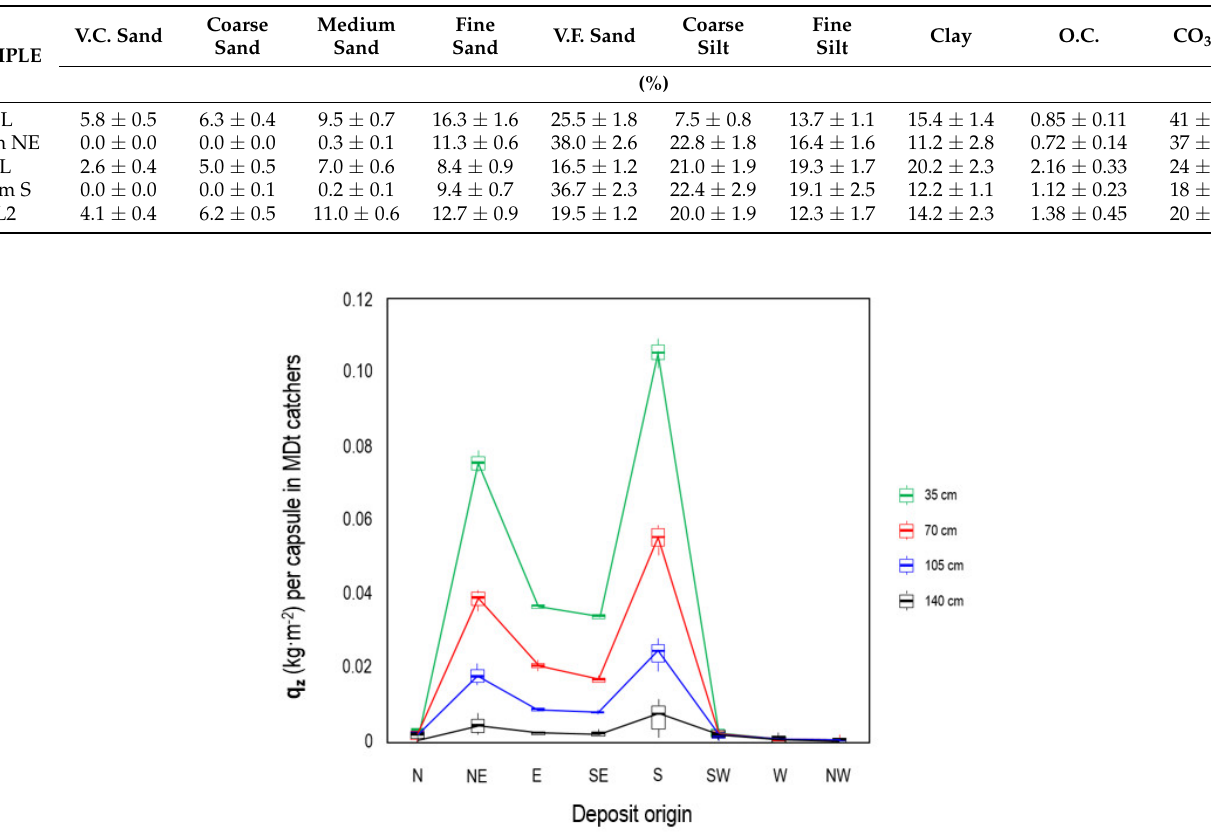
Table 2. Characteristics of soils and sediments in MDt compartments.